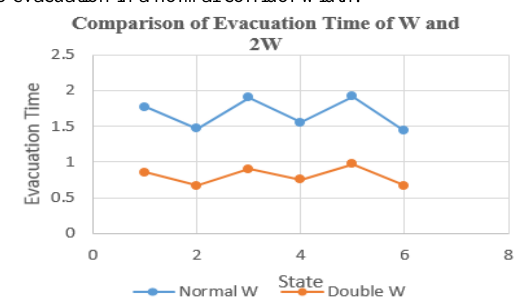
Figure 12. Comparison of corridor width and